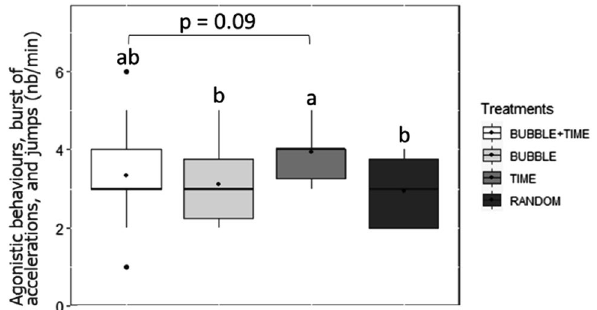
Figure 4. Median (quartiles: 25%, 75%) number of agonistic behaviours, burst of accelerations, and jumps scored per minute in the whole tank over 6 min preceding feed delivery in the four treatments. The black point inside boxes represents the mean value. Different letters indicate significant differences between treatments ( P < 0.05; Tukey post-hoc tests).